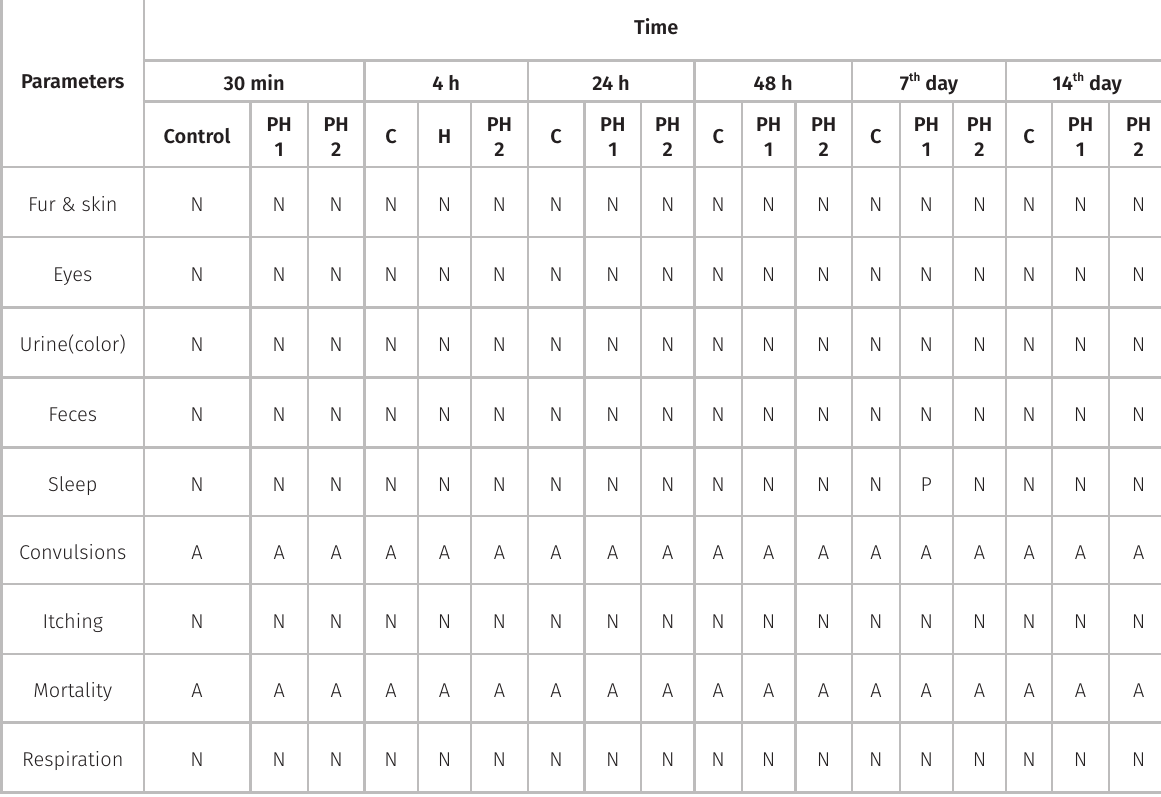
Table II. Behavioral patterns of rats at a limit dose (2000mg/kg P.O.) in acute toxicity study.